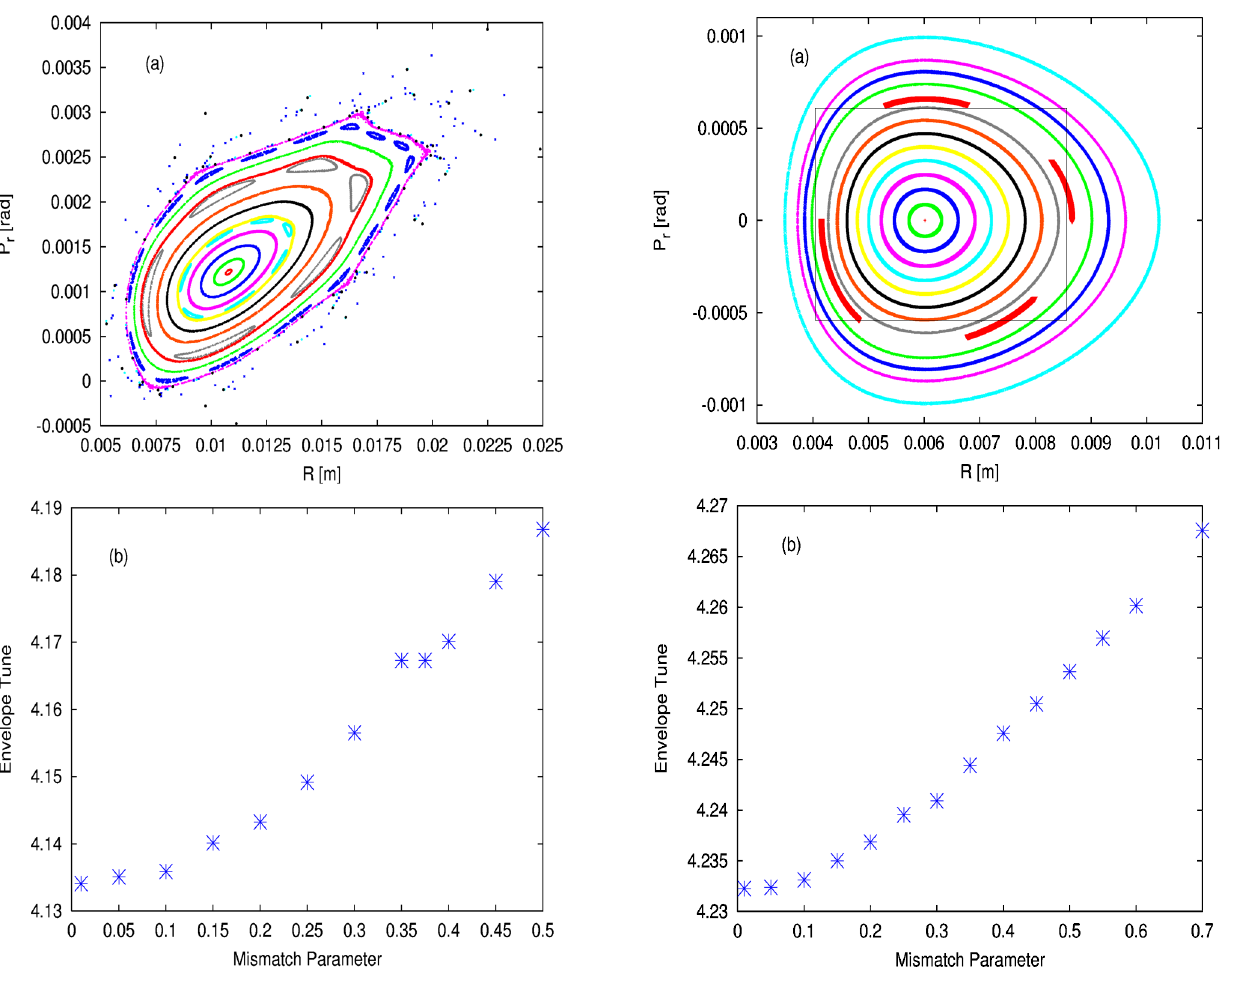
9. (Color) (a) Stroboscopic map of the envelope in the PSR lattice for the full PSR beam intensity listed in Table I and emittances representative of the PSR beam at this intensity. The colors represent varying levels of mismatch. (b) Envelope tune versus